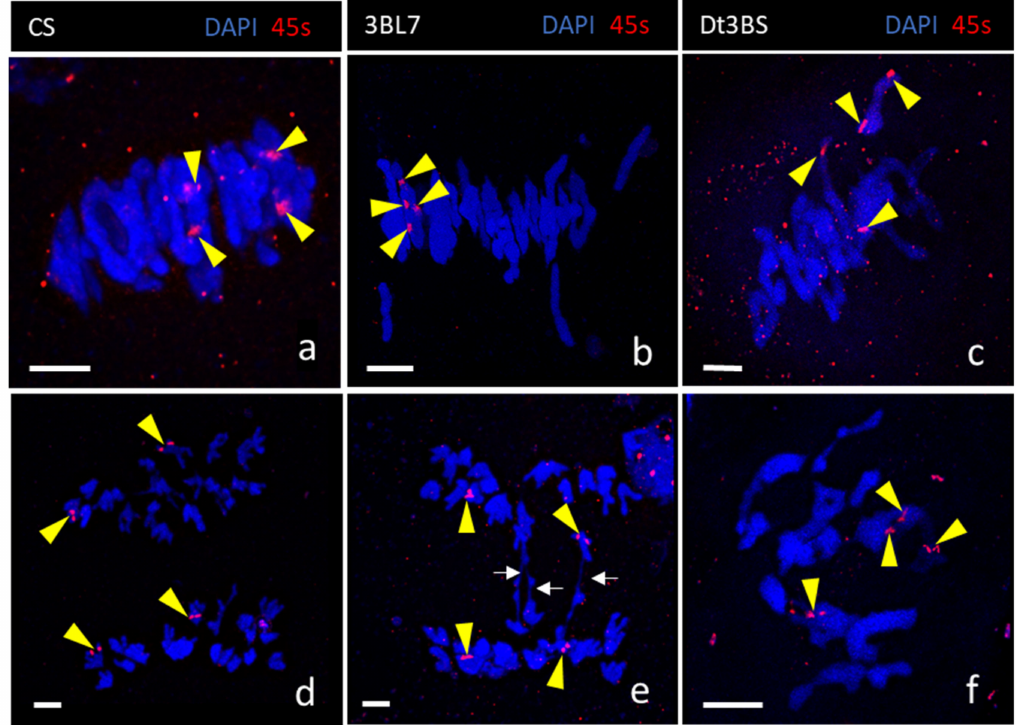
Figure 4. Homologous chromosome pairing and segregation at Metaphase I and Anaphase I in lines CS ( a,d ), 3BL7 ( b,e ) and Dt3BS ( c,f ). Homologous pairing was monitored using the 45S-rDNA probe. All lines exhibit correct homologous chromosome pairing as shown by the localisation of two 45s signal (red, yellow arrows) per bivalent (DAPI blue). Homologous chromosomes halve at anaphase I in both CS ( d ) and 3BL7 ( e ), with occasional chromosome bridges (white arrows) in 3BL7. We could not find a similar stage for Dt3BS. Moreover, Dt3BS chromosomes were “fuzzier” and stickier at Metaphase I ( f ) than in the other lines, making chromosome spread for 3D DNA in situ hybridization in this line more challenging. Scale bar 10 µ